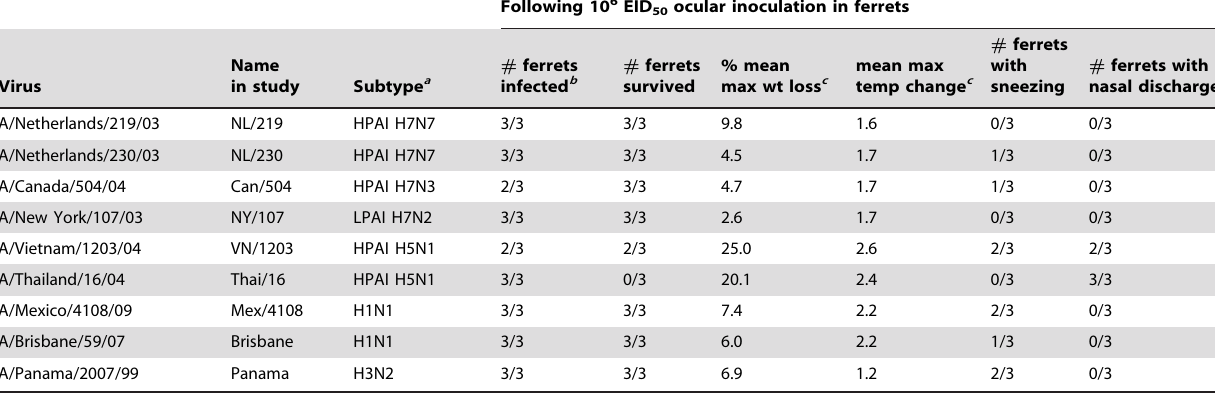
Following 10 6 EID 50 ocular inoculation in